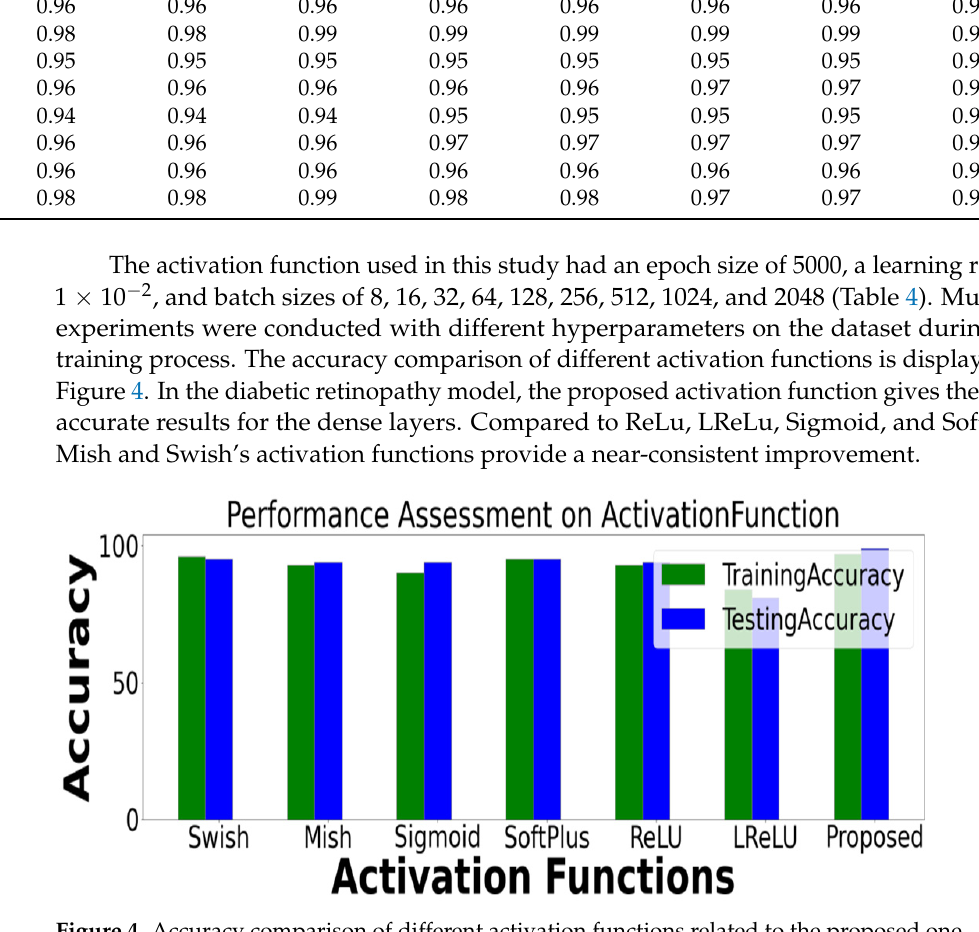
Figure 4. Accuracy comparison of different activation functions related to the proposed one.